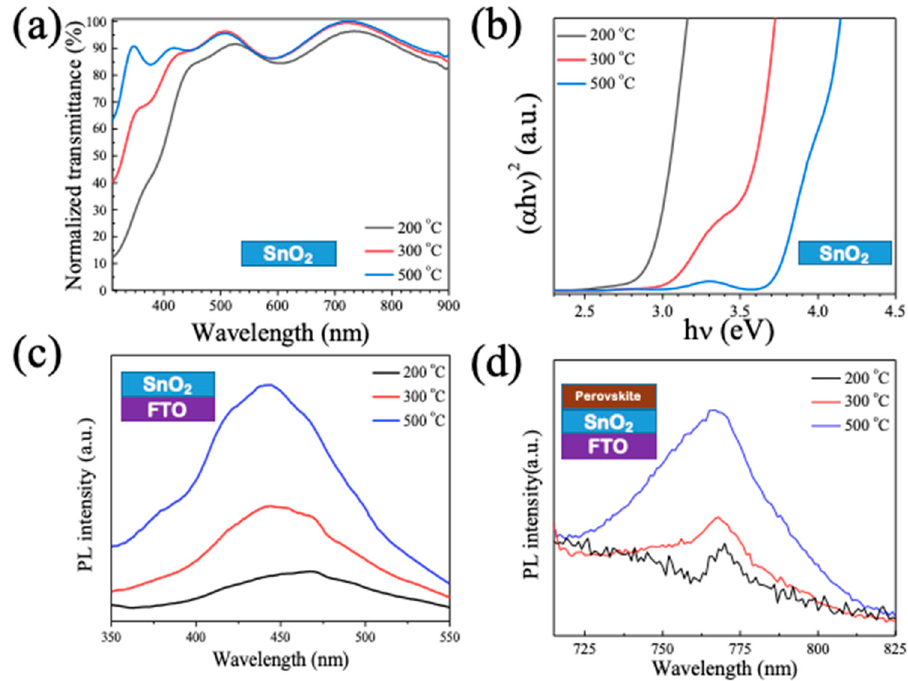
Figure 3. Characteristics of the SnO 2 thin films annealed at various temperatures: ( a ) normalized transmittance spectra ( b ) Tauc plots, and ( c ) PL spectra without and ( d ) with a perovskite layer.